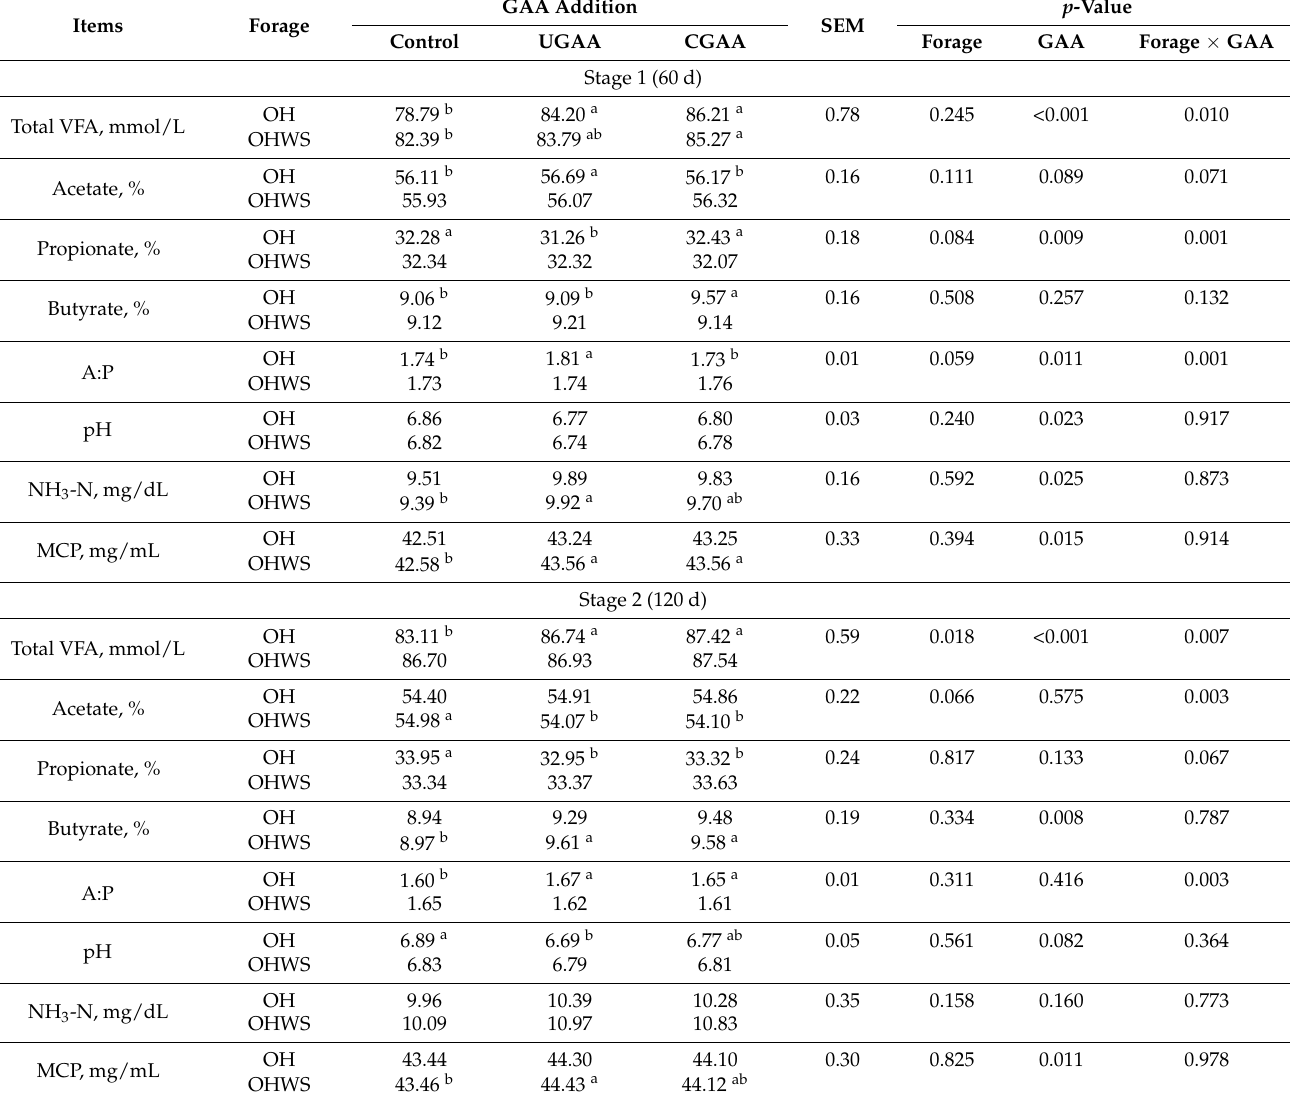
Table 1. Effects of forage type and GAA addition on rumen fermentation in feedlotting